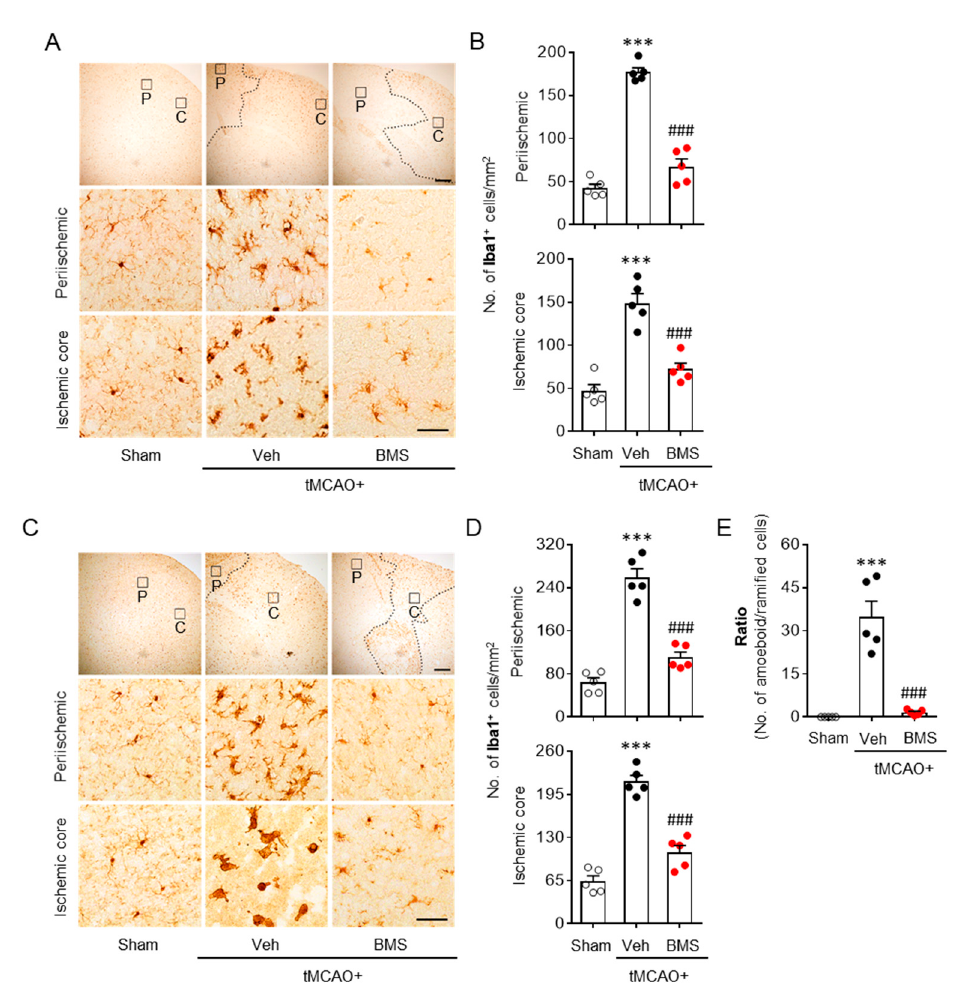
Figure 2. BMS administration attenuates microglial activation in mice at one day and three days after tMCAO challenge. Mice were challenged with tMCAO. BMS (5 mg/kg) was administered to mice immediately after reperfusion. Effects of BMS on tMCAO-induced microglial activation were assessed at one day ( A , B ) and three days ( C – E ) after tMCAO challenge. Representative images of Iba1-positive cells ( A , C ) in periischemic (P) and ischemic core ( C ) regions. Scale bars, 200 μ m for top and 50 μ m for middle and bottom. Quantification of Iba1-positive cells in periischemic and ischemic core ( B , D ) regions. ( E ) Quantification of ratio of amoeboid to ramified cells at three days after tMCAO challenge. n = 5 mice per group. *** p < 0.001 versus sham. ### p < 0.001 versus vehicle-administered tMCAO mice (Veh + tMCAO).